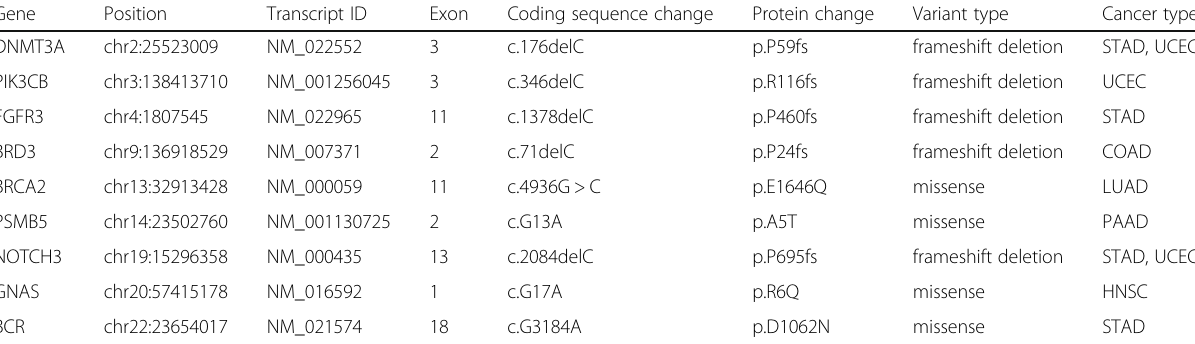
Table 2 Consistent mutations shared with the sample from TCGA database